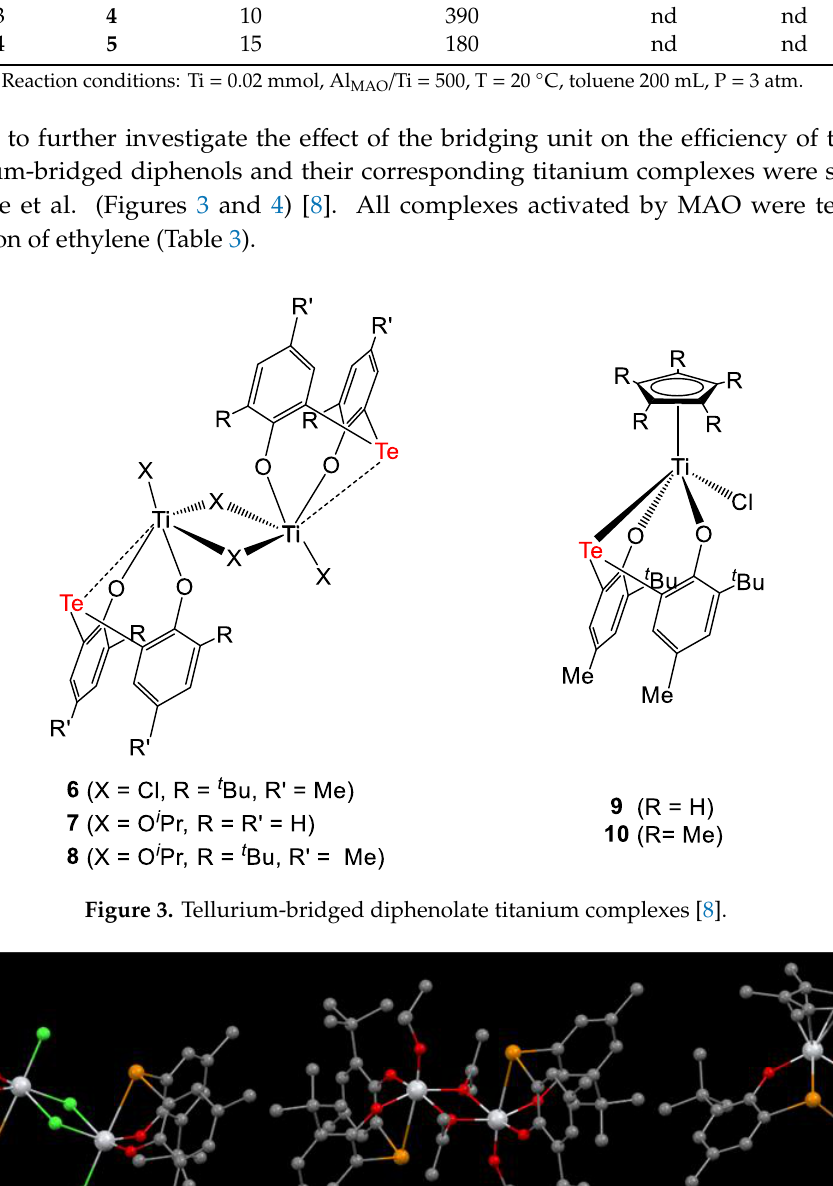
Table 2. Ethylene polymerization catalyzed by 1 , 3 , 4 and 5 /MAO systems [7].